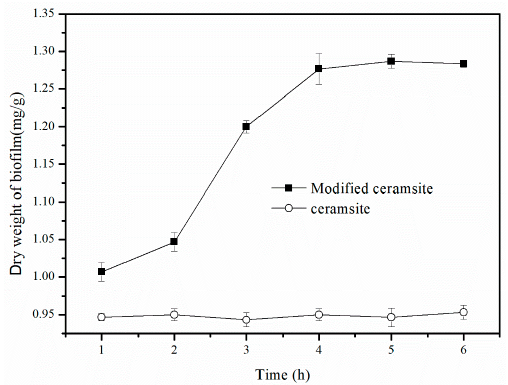
Figure 3. Dry weight of biofilm under different calcination time (1, 2, 3, 4, 5 and 6 h) of the modified ceramsite.